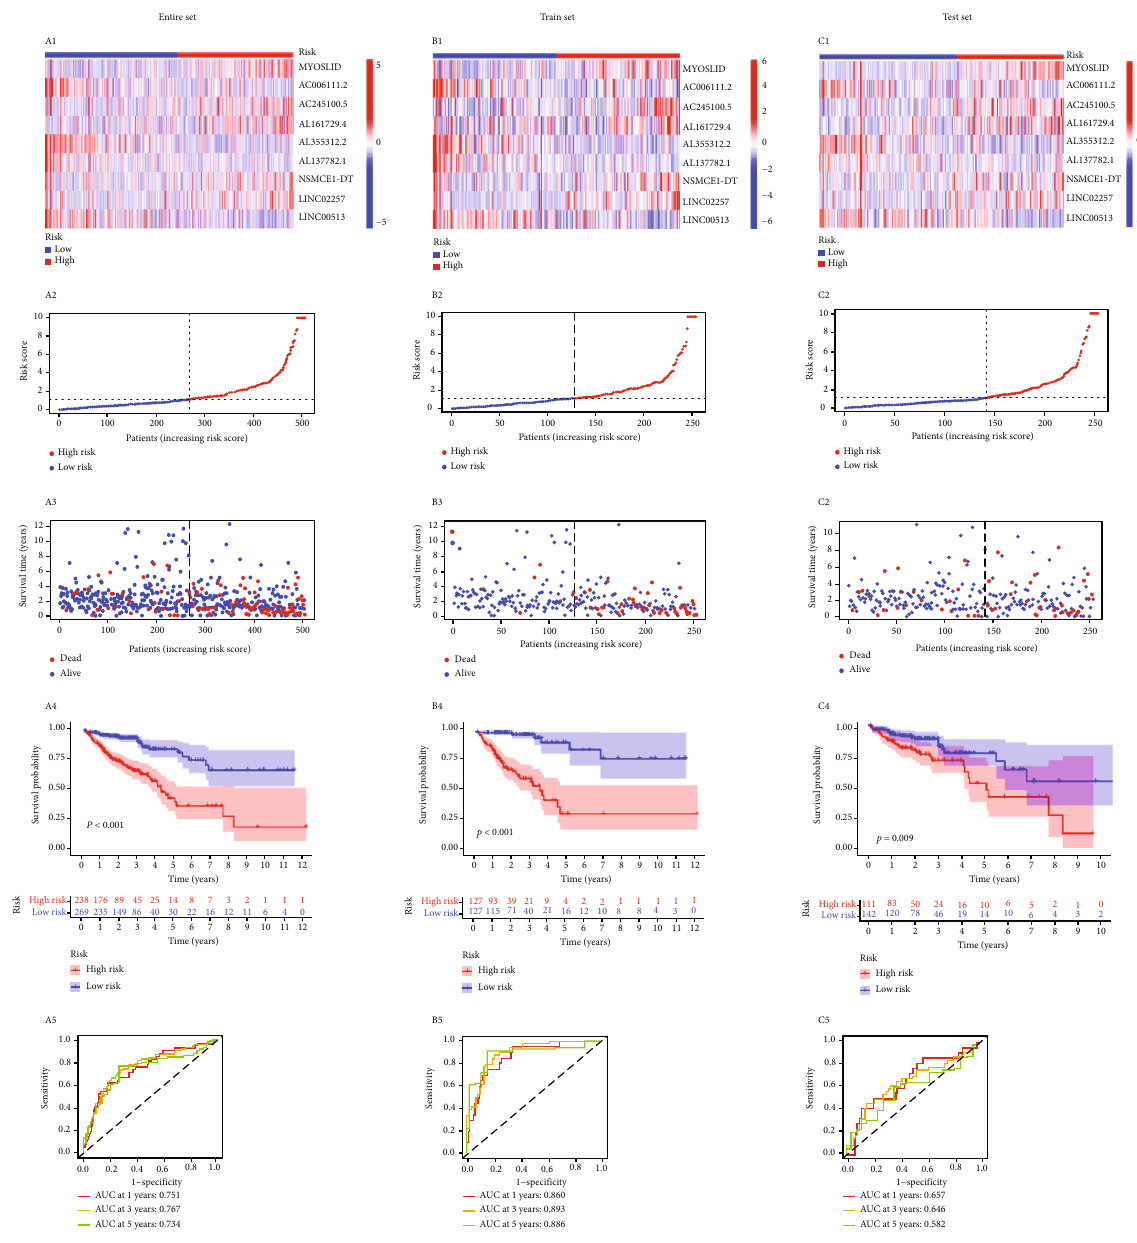
Figure 4: Validation of necroptosis-related lncRNAs ’ prognostic signature for CRC. (a1 – a5) Expression of 9 nrlncRNAs for signature in high- and low-risk groups, the distribution of the risk score, survival status, the Kaplan – Meier survival curve, and the time-dependent ROC curve analyses of the prognostic signature in the entire set. (b1 – b5) The demonstration mentioned above in the train set. (c1 – c5) The demonstration mentioned above in the test key diagram (Figure 2(a)) showed the connections between